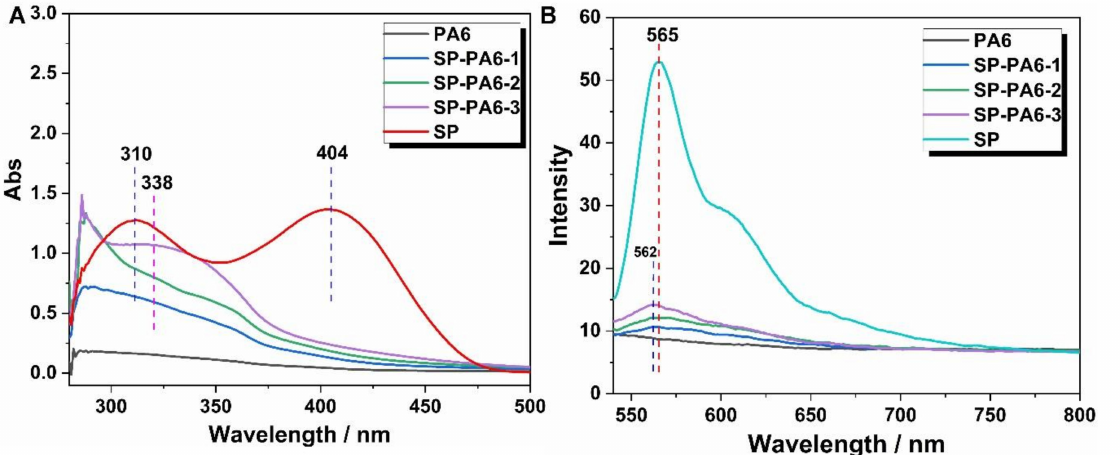
Figure 4. ( A ) UV-visible absorbance spectra and ( B ) fluorescence spectra of PA6 and SP-modified PA6 in formic acid (0.03 g/mL) at 298 K ( λ ex = 523